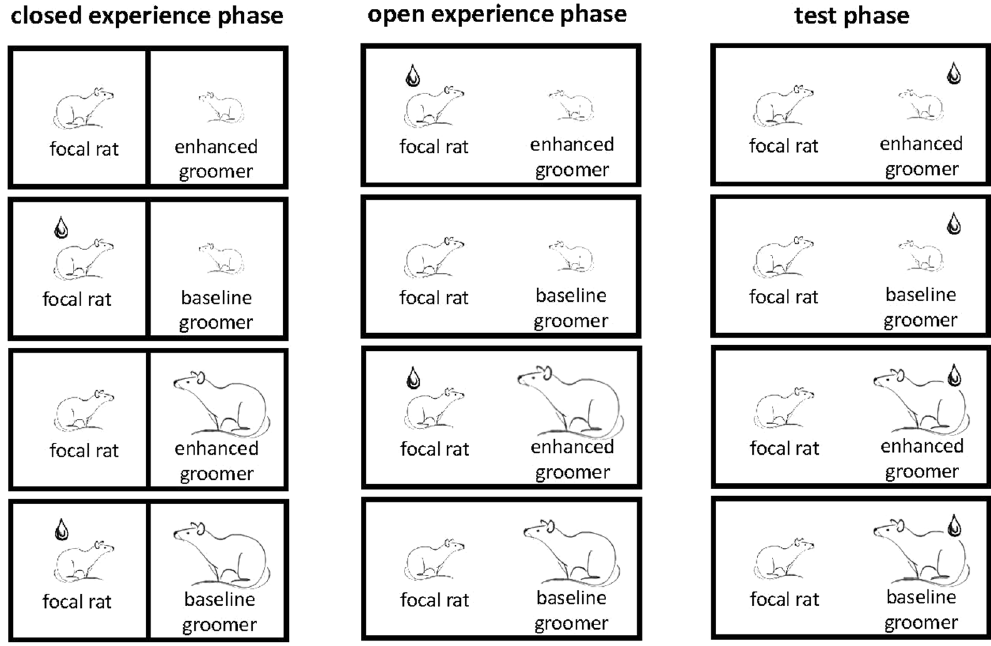
Figure 1. Test procedure. Every focal rat experienced all four treatments (lines from top to bottom) in a randomized order. In the example shown, the focal rat first experienced a subordinate partner (depicted small in graph) as being a cooperative groomer ( = grooming at an enhanced level), by applying saltwater on the focal rat’s neck during the open experience phase, in which the partner had the possibility to allogroom the focal rat (first line). The same partner was experienced as being non-cooperative when we applied saltwater during the closed experience phase (second line), in which the partners were physically prevented from allogrooming by a separating mesh. We repeated the same treatments with a dominant cage mate (depicted large in graph; lines 3 and 4). We recorded during the test phase when and how often focal individuals groomed the previously experienced partner, which was now treated with saltwater to induce allogrooming of the focal individual. Drawings were kindly provided by Valentina